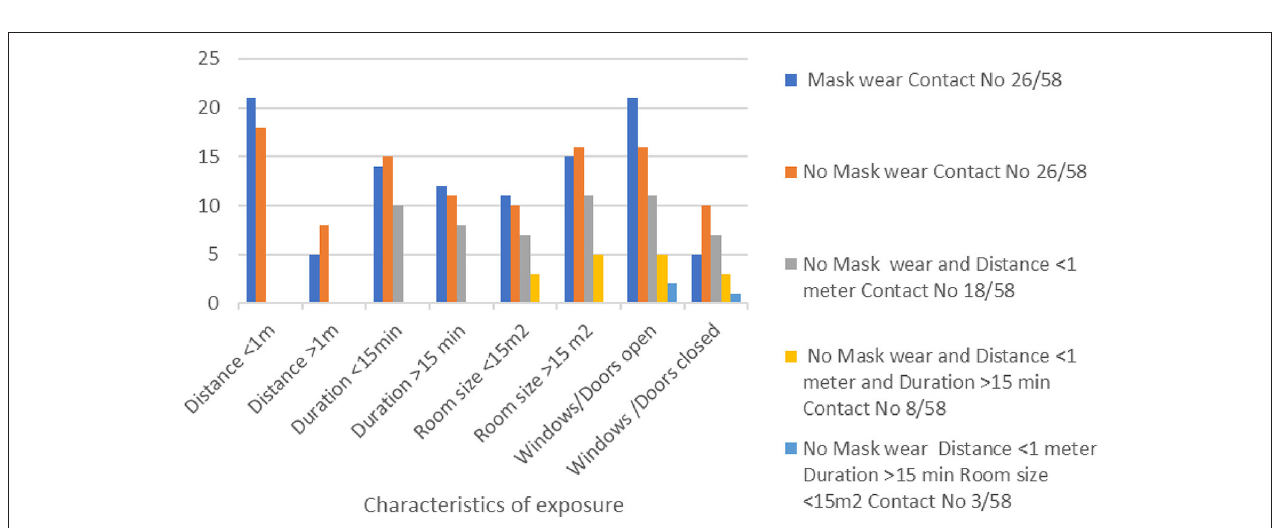
FIGURE 1 | Characteristics of the contact of healthcare workers ( N = 58) with three patients with SARS-CoV-2, with and without masks.